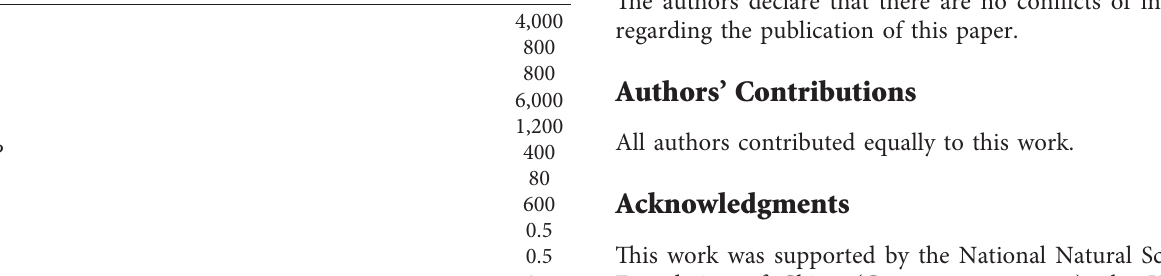
Conflicts of Interest Table 1: Parameter settings for the case analysis.